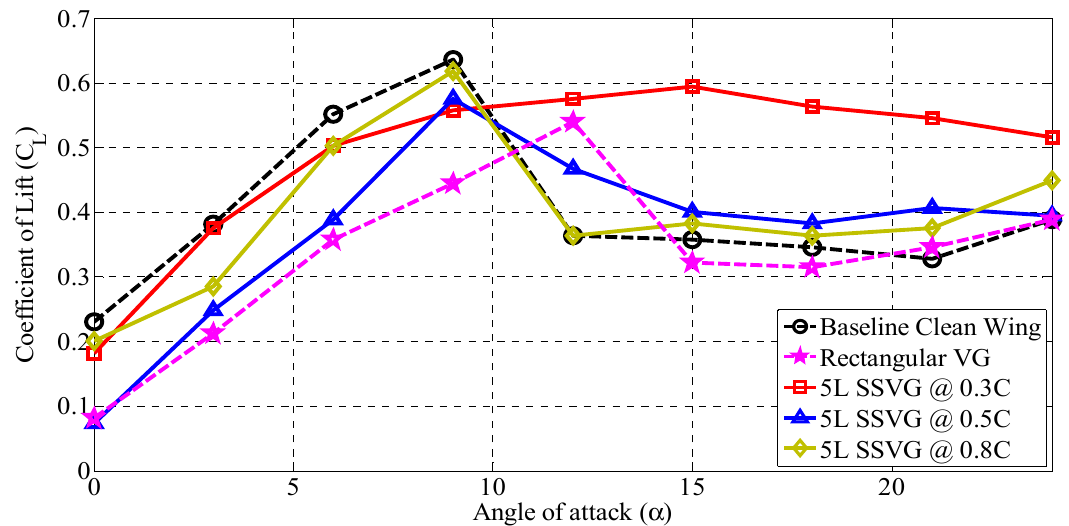
Figure 14. Coefficient of lift ( C L ) vs. angle of attack ( α ) for baseline and modified model with large-sized (5L) shark scale vortex generators (SSVG).